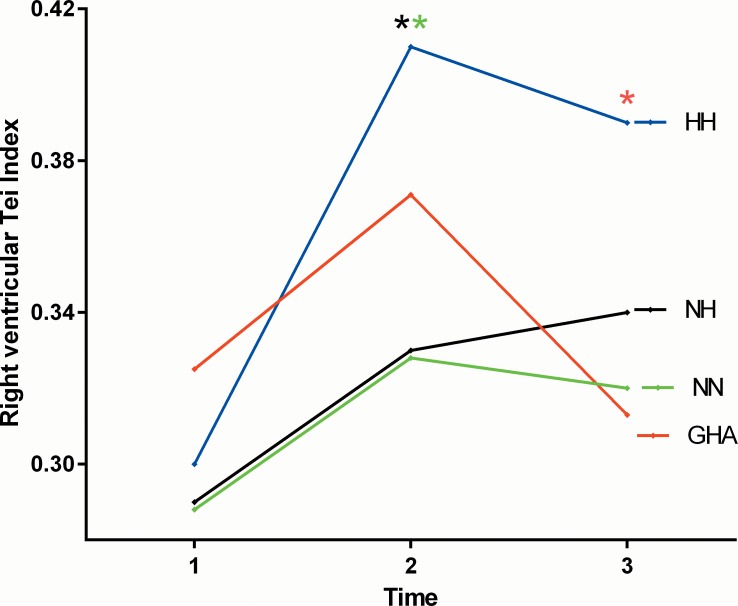
Changes in the right ventricular Tei Index (marginal means) with differing experimental conditions and duration of hypoxia (time 1 = baseline rest, time 2 = 15 minutes post exercise and time 3 = 120 minutes post exercise) * demonstrates between group differences on post test.